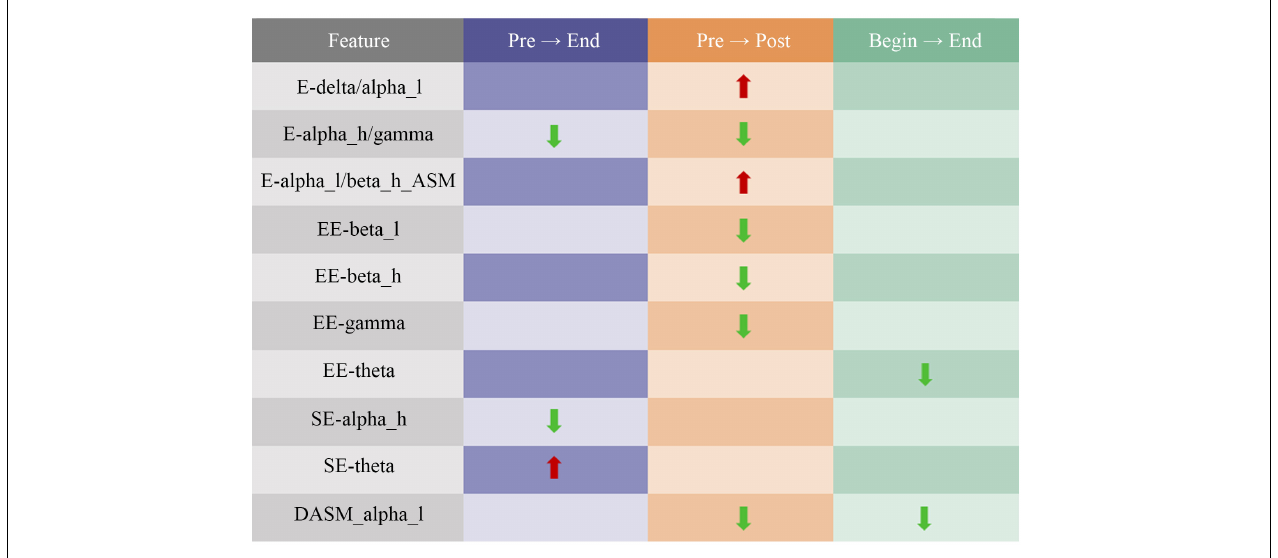
FIGURE 8 | Summary of changes in electroencephalogram (EEG) characteristics of normal participants after watching the relaxation scenes.